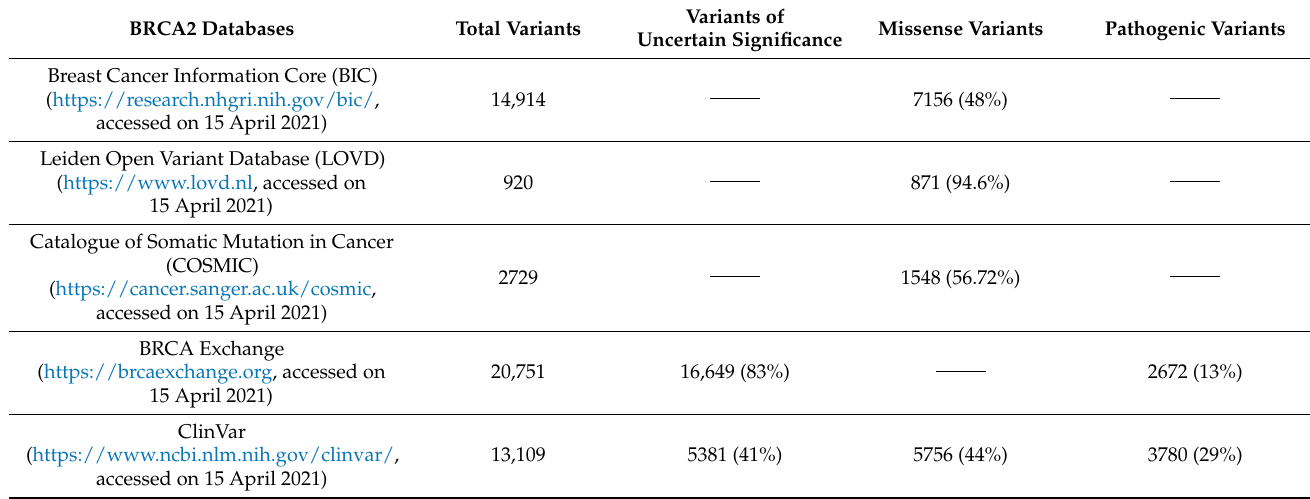
Table 2. Clinical Significance Databases with BRCA2 mutations (Updated April 2021).